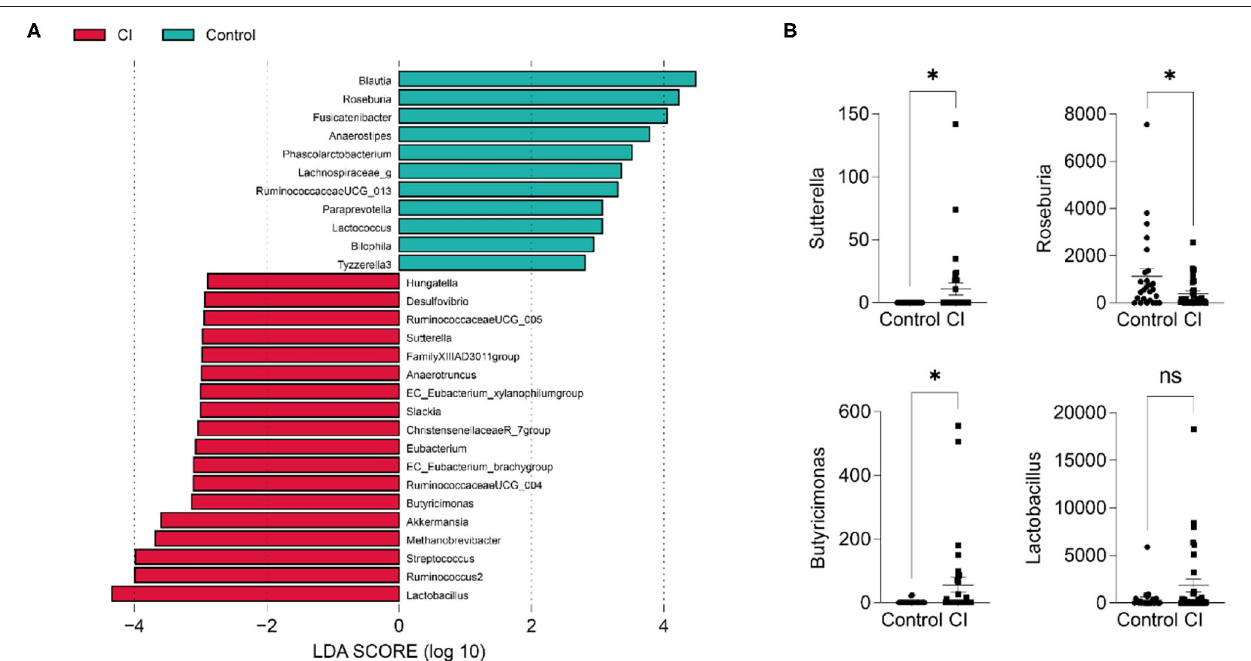
FIGURE 4 | Differential taxa in the control and CI groups. (A) Linear discriminant analysis effect size (LEfSe). (B) Comparisons of 4 genera between groups (unpaired t-test, ns, no significance, * p < 0.05).